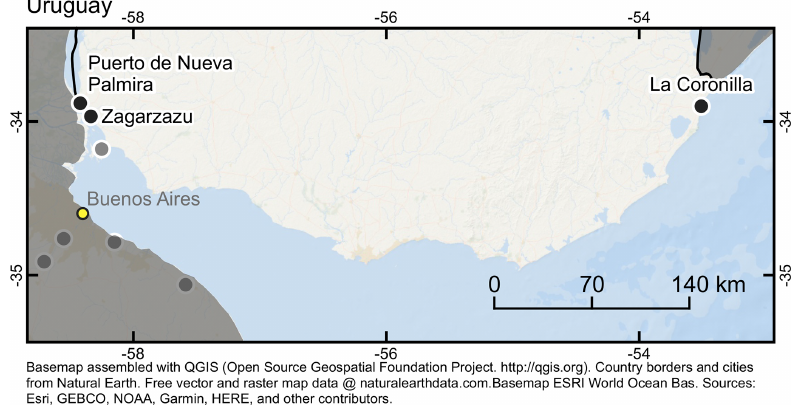
Figure 6. MIS 5 sea-level indicators in Uruguay (black circles).